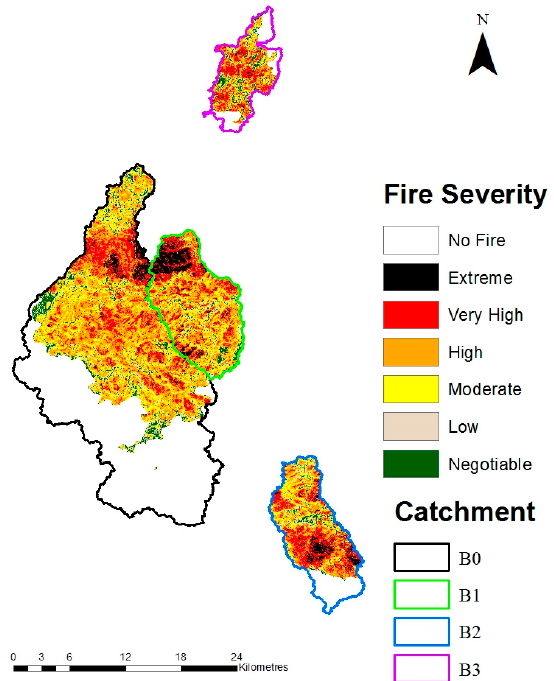
Figure 2. Wildfire severity maps of burnt catchments. Abbreviations: B = Burnt (Source: [35]).